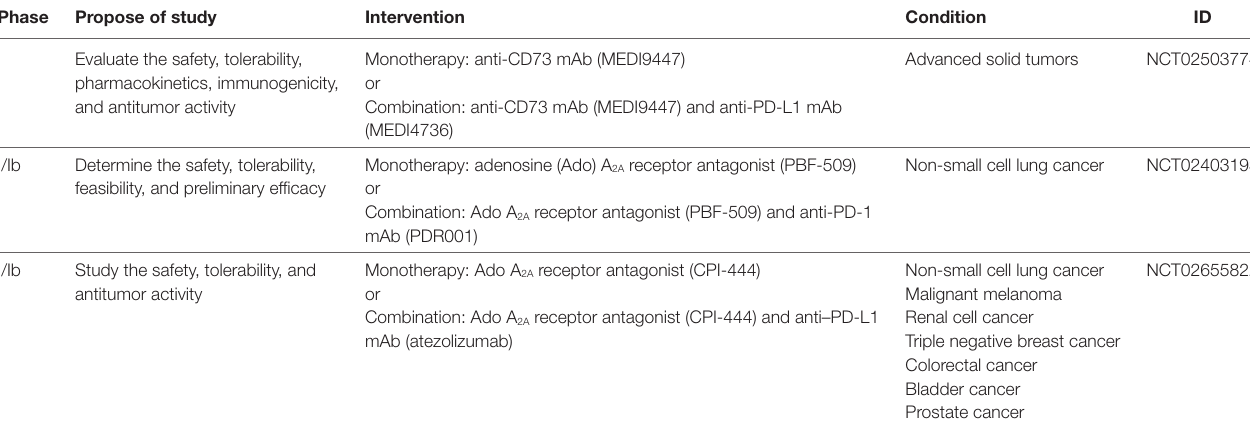
TABLe 1 | Clinical trials currently underway that are testing the potential use of anti-CD73 mAb and A 2A antagonists alone or in combination with other immunotherapies to treat cancer.